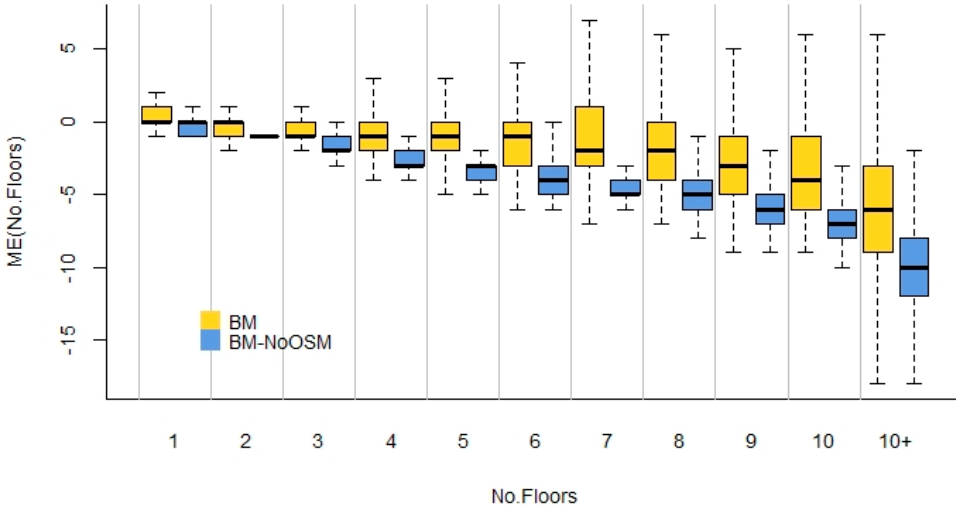
Figure 7. Mean error (ME) reported in the number of floors by each BM for all the studied